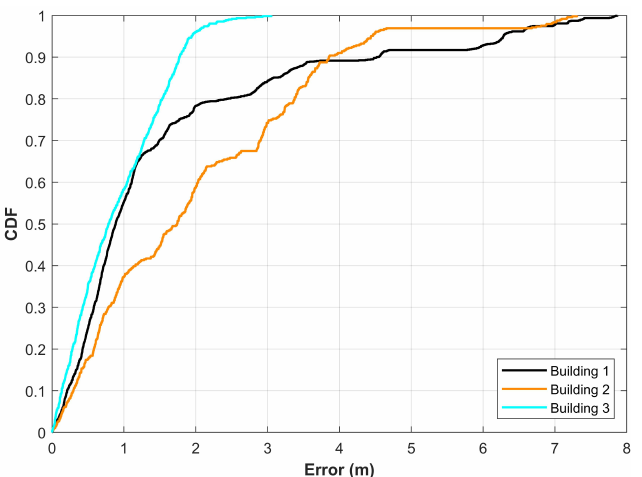
Figure 6. Results for magnetic field-based positioning in three buildings with different indoor environment and